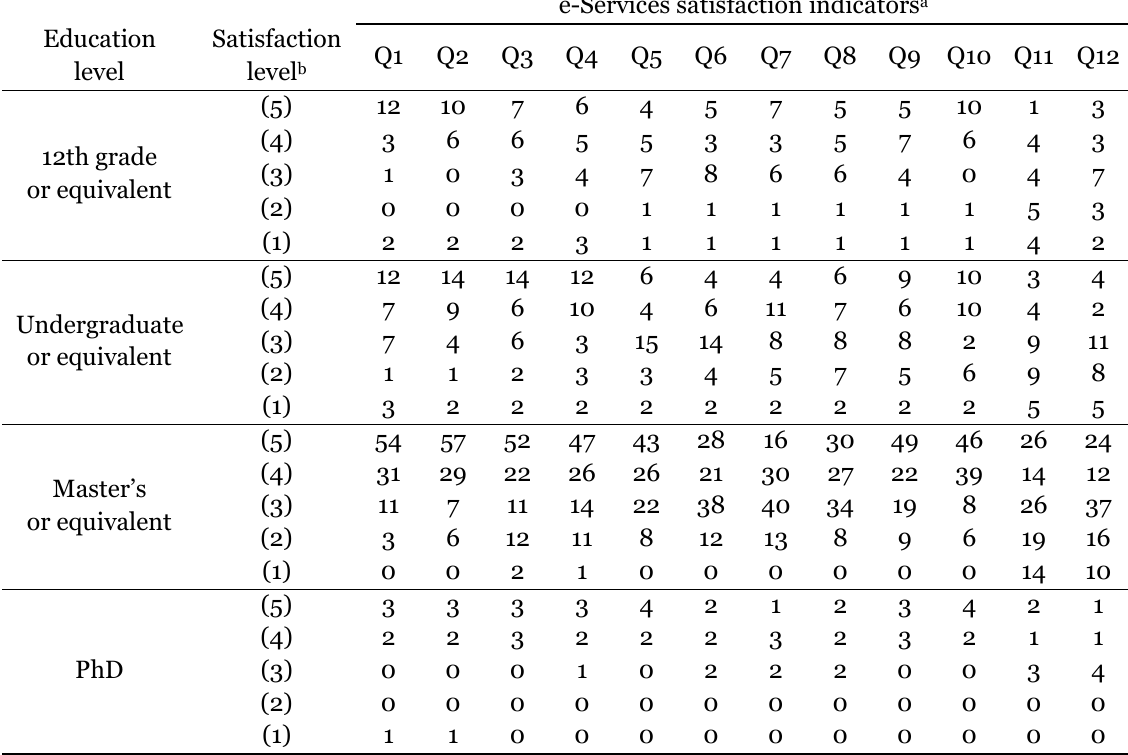
e-Services satisfaction indicators